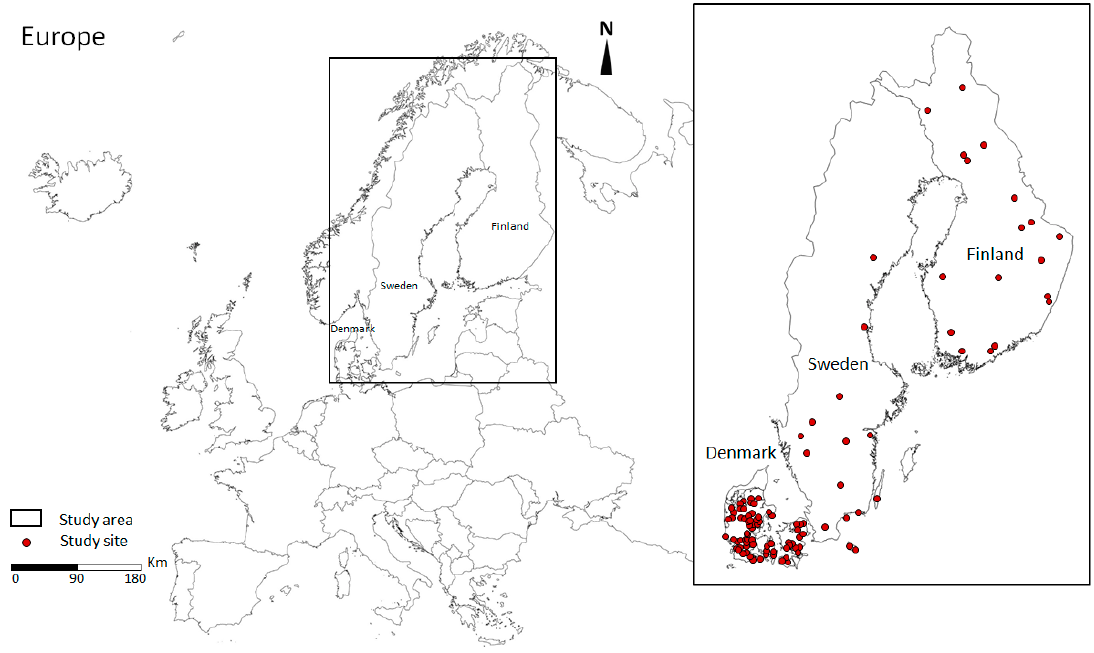
Figure 1 . Locations of the mini-catchments investigated in the study. Figure 1. Locations of the mini-catchments investigated in the study. Table 1. Numbers of stations and total number of nutrient monitoring concentrations for N (nitrate and total organic N) and P forms (dissolved reactive P and particulate P) per year for streams in Denmark, Sweden, and Finland, including mean, range, and standard deviation